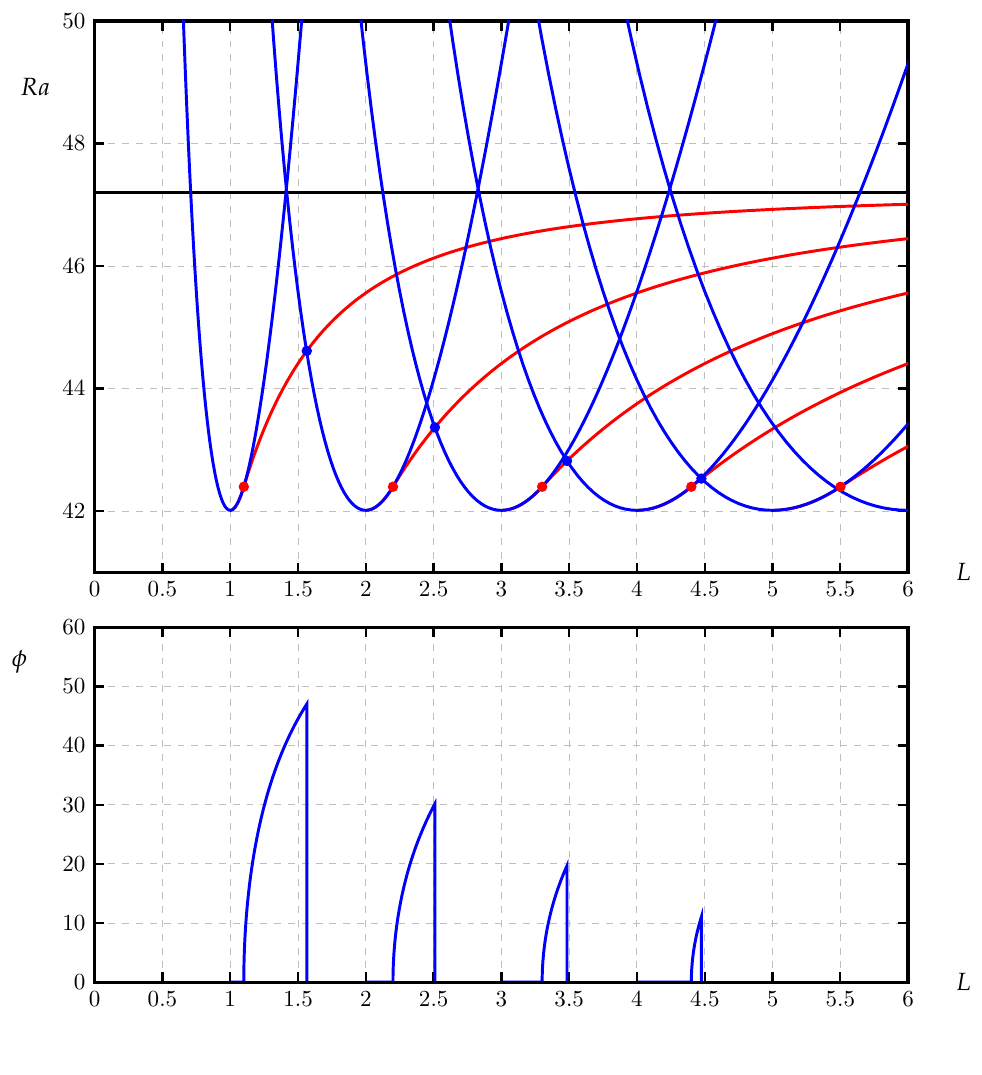
Figure 5. As Figure 4 but for α = 20 ◦